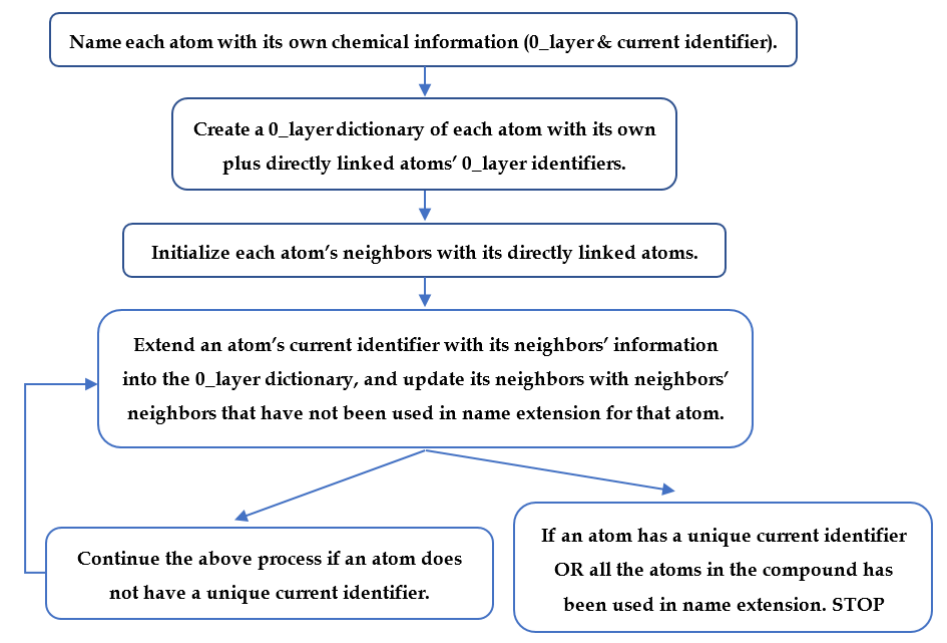
Figure 12. Flow chart of atom coloring.